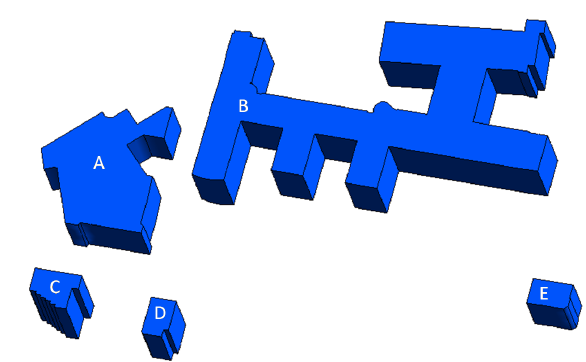
Figure 2. A part of a building block in Stuttgart.